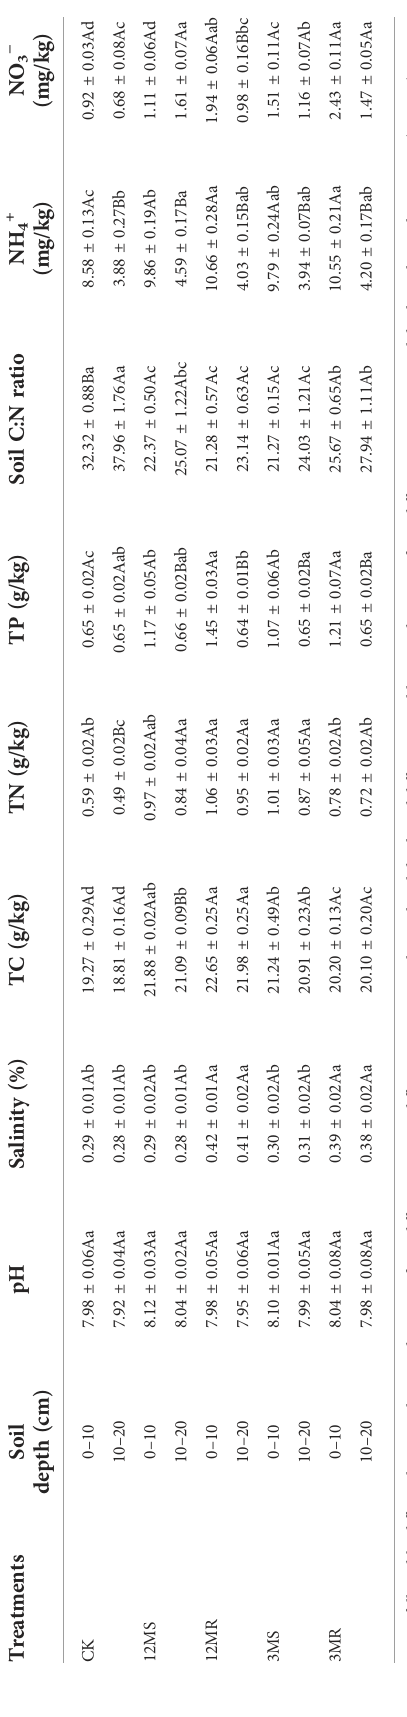
Figure 3C). Compared with CK, the 12MR, 12MS, 3MR, and 3MS treatments in the 10- to 20-cm soil layer signi fi cantly increased DOC content by 39.55%, 14.92%, 22.16%, and 43.65%, respectively ( P < 0.05, Figure 2C). The 12MR and 12MS treatments in the 0- to 10-cm soil layer obtained signi fi cantly higher LOC content than the CK treatment, with average increases of 24.76% and 26.27%, respectively ( P < 0.05, Figure 2D). In the 10- to 20-cm soil layer, only the 12MS treatment signi fi cantly enhanced LOC by 70.45% ( P < 0.05, Figure 2D). Compared with that under the CK treatment, POC content in the 0- to 10-cm soil layer elevated signi fi cantly under the 12MR, 12MS, 3MR, and 3MS treatments by 30.00%, 35.54%, 27.95%, and 57.27%, whereas POC content in the 10- to 20-cm soil layer increased signi fi cantly under four treatments by 33.60%, 32.36%, 39.40%, and 49.04%, respectively ( P < 0.05, Figure